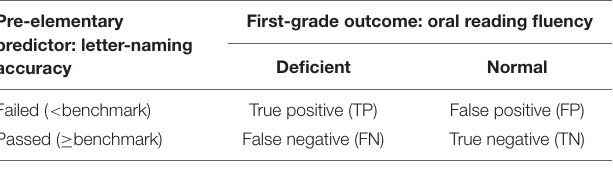
TABLE 1 | Structure of contingency matrix based on longitudinal data. Pre-elementary predictor: